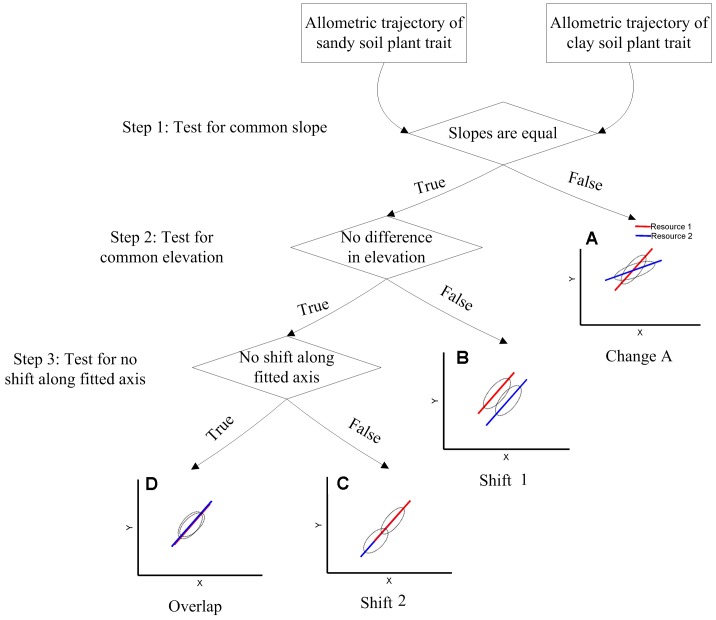
Three steps and four types in making inferences about two lines.Four types: (A) Change is defined as the slopes are not equal in the two soil textures; (B) Shift 1 is defined as the slopes are equal but the intercepts are differences in the two soil textures; (C) Shift 2 is defined as the slopes are equal, and the intercepts are no differences in the two soil textures, but are shifted in location along common slope SMA lines; (D) Overlap is defined as no difference in slopes, no difference in intercept and no shift location along common slope SMA lines.